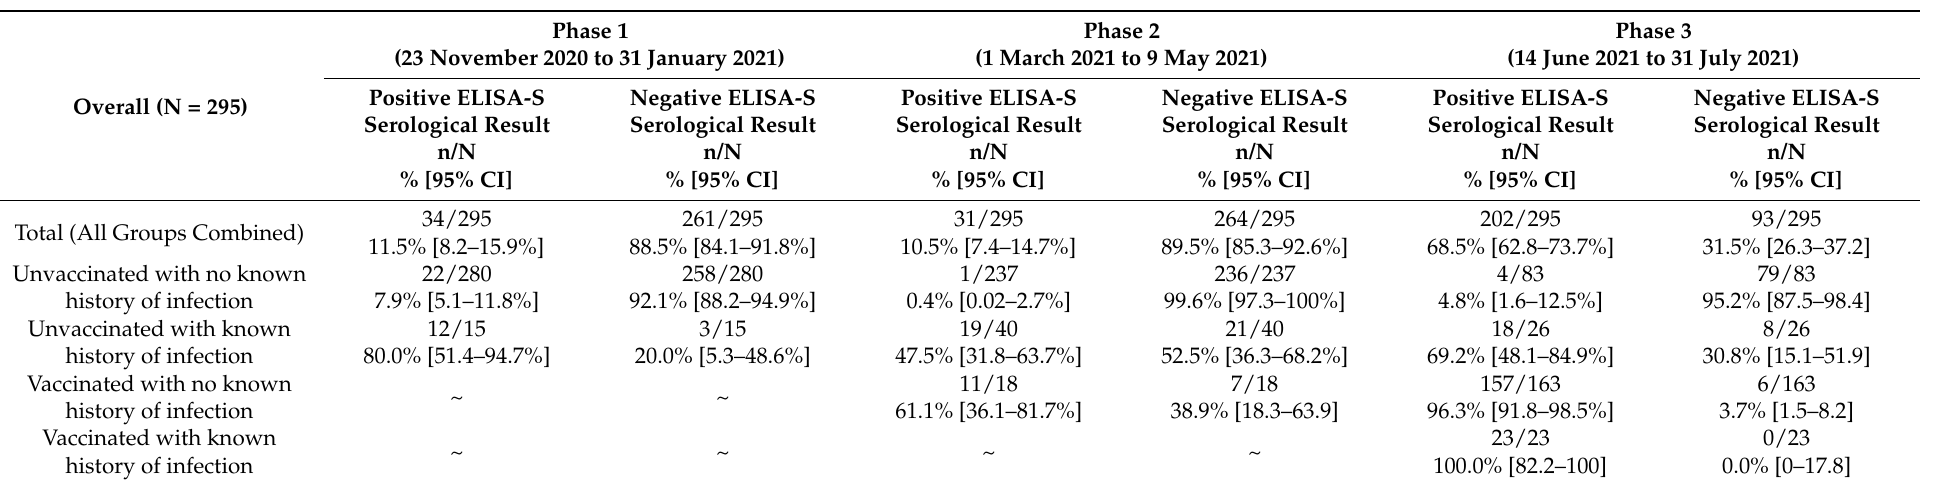
Table 3. ELISA-S results according to participants’ immune